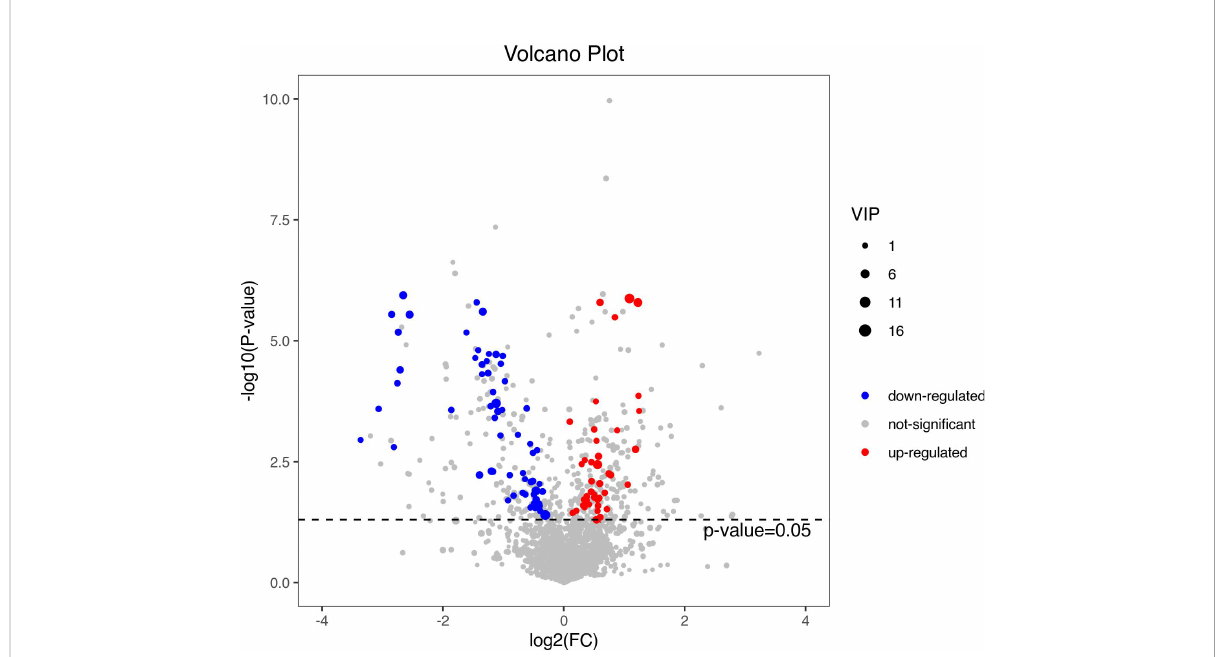
FIGURE 6 A volcano plot of the differential metabolites. The volcano map can be used to visualize p value, VIP value and FC value, which is bene fi cial to screen differential metabolites. The red and blue dots represent signi fi cantly up-regulated and down-regulated DEMs,